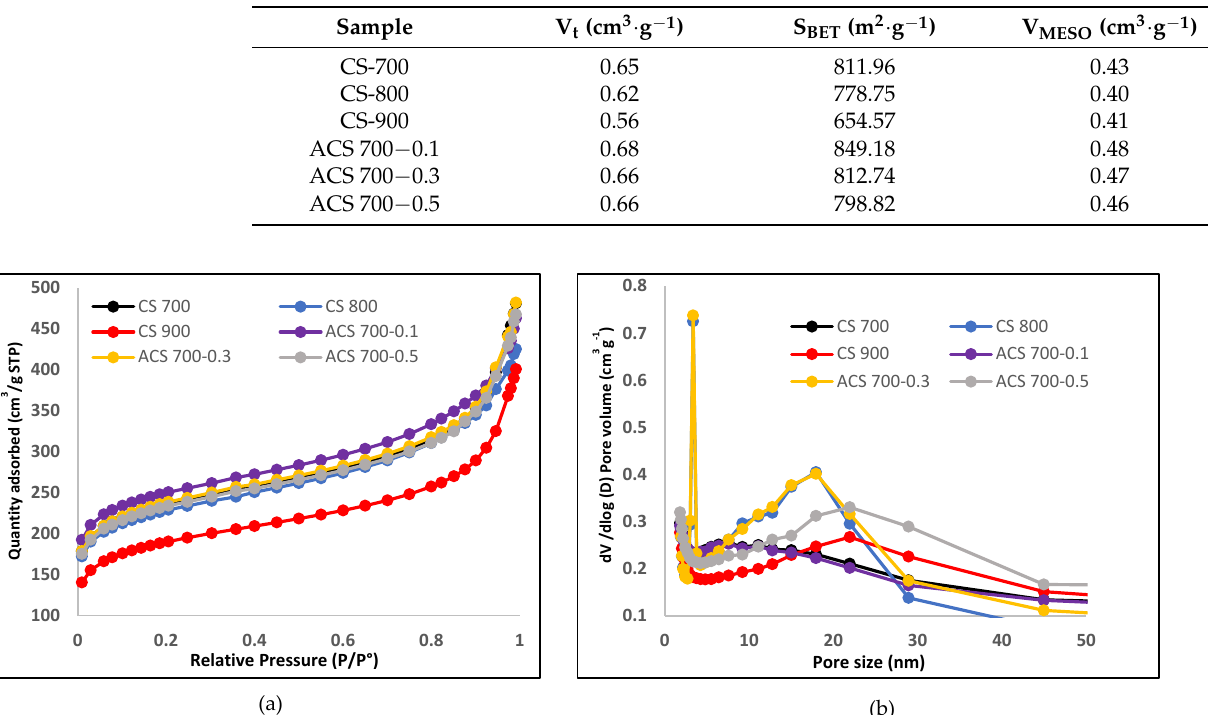
Table 3. Textural parameters of CS 700, CS 800, CS 900, ACS 700 − 0.1, ACS 700 − 0.3, and ACS